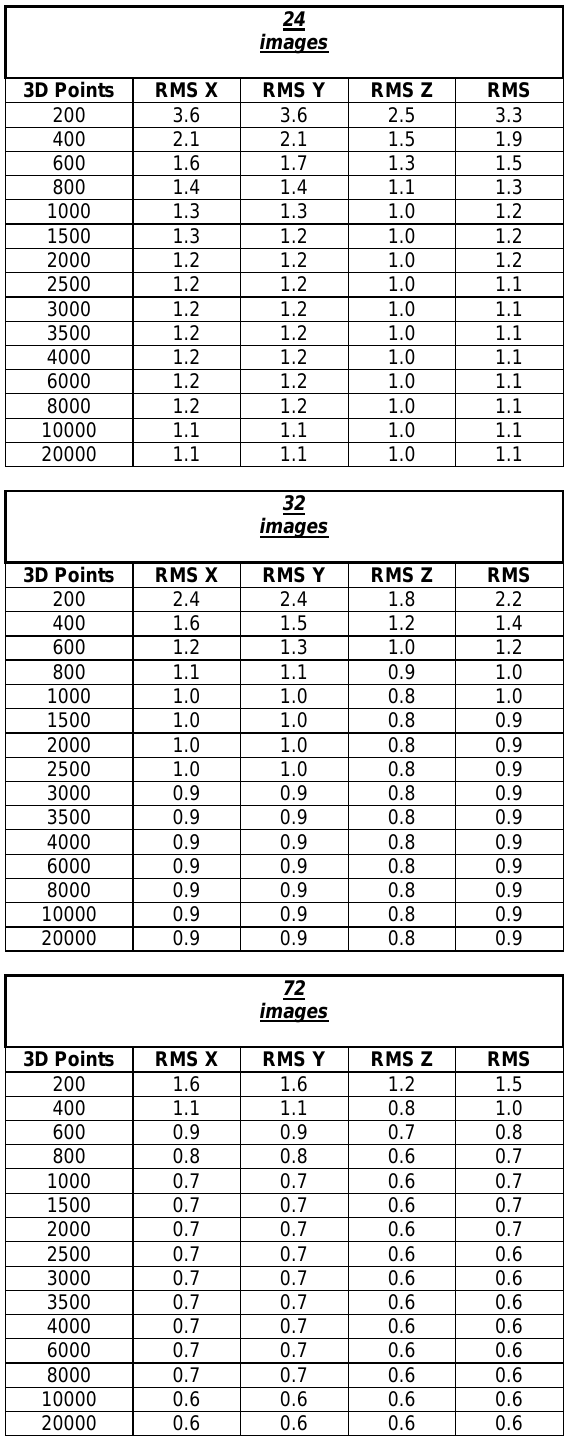
Table 2. Precision of 3D points for the closed sequence with a variable number of images and 3D